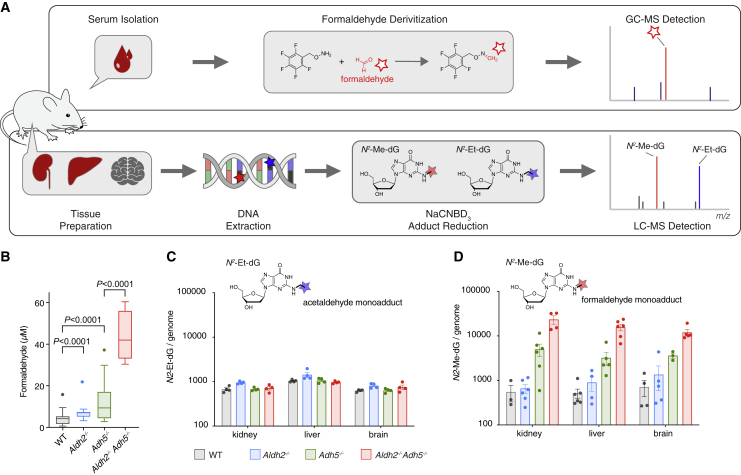
Aldh2 and Adh5 Act to Suppress Blood Formaldehyde Levels and Its DNA Adduct in Tissues(A) Scheme of formaldehyde quantification in serum and as DNA adduct in tissues.(B) Serum levels of formaldehyde (n = 43, 20, 51, 4, left to right). Boxes with lines indicate quartiles and median, and Tukey whiskers extend to 1.5 interquartile ranges. Two-tailed Mann-Whitney U test.(C) Determination of the reduced genomic AA-deoxyguanine adduct N2-ethyl-deoxyguanosine from kidneys, liver, and brain (mean ± SEM; n = 4 per group).(D) Determination of the reduced genomic formaldehyde-deoxyguanine adduct N2-methyl-deoxyguanosine from mouse kidneys, liver, and brain (mean ± SEM; n = 3–6 per group).See also Figure S5.